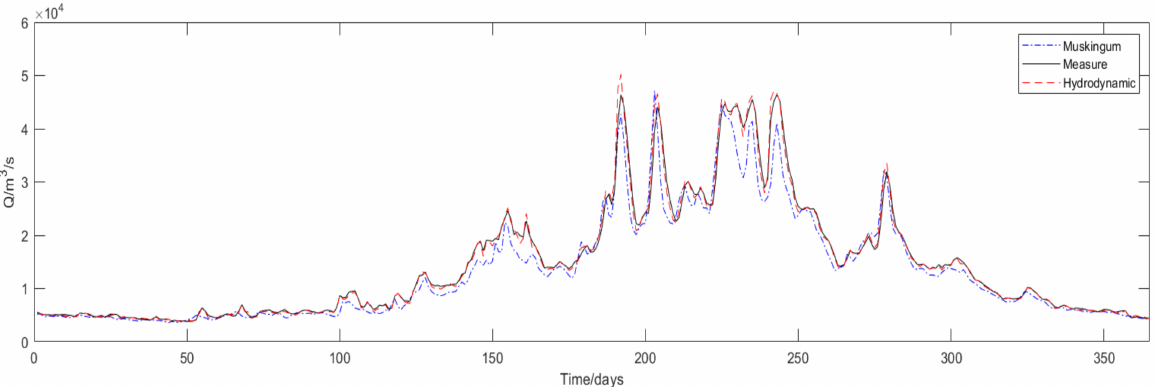
Figure 5. Comparison of the results from the Muskingum method and the hydrodynamic model with measured data from